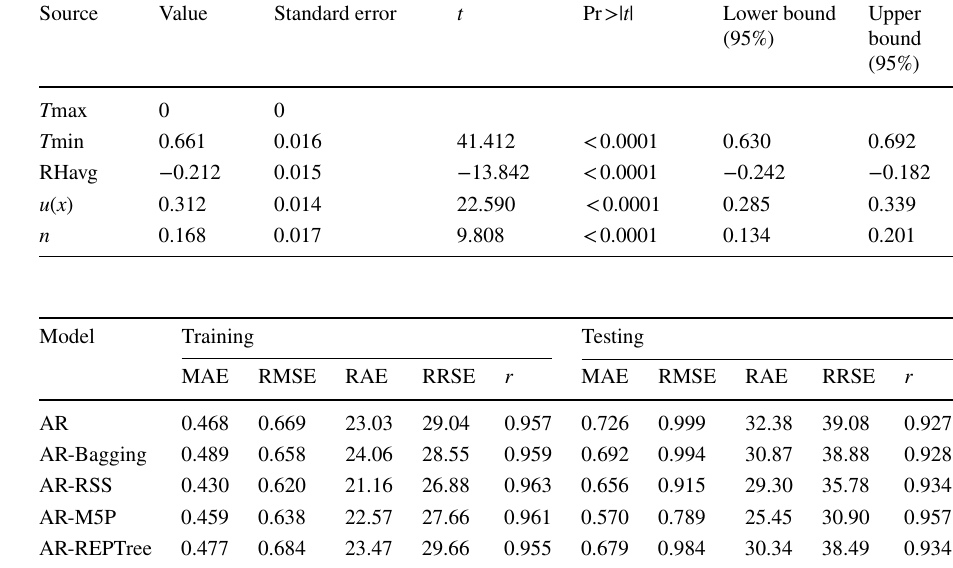
Table 5 The regression analysis for identifying the most effective parameters for ET o estimation at Islamabad station